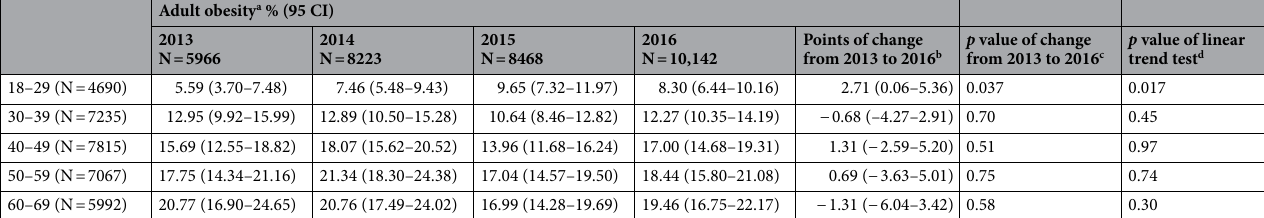
Table 2. Linear trend of obesity by age, weighted and age and sex-adjusted prevalence, 2013–2016 in women (N = 32,799). a Adult obesity defined as BMI ≥ 30 kg/m 2 . b Percentage point. c From the t-test of the change from 2013 to 2016. d From the coefficients of orthogonal polynomials corresponding to linear contrast. Age and